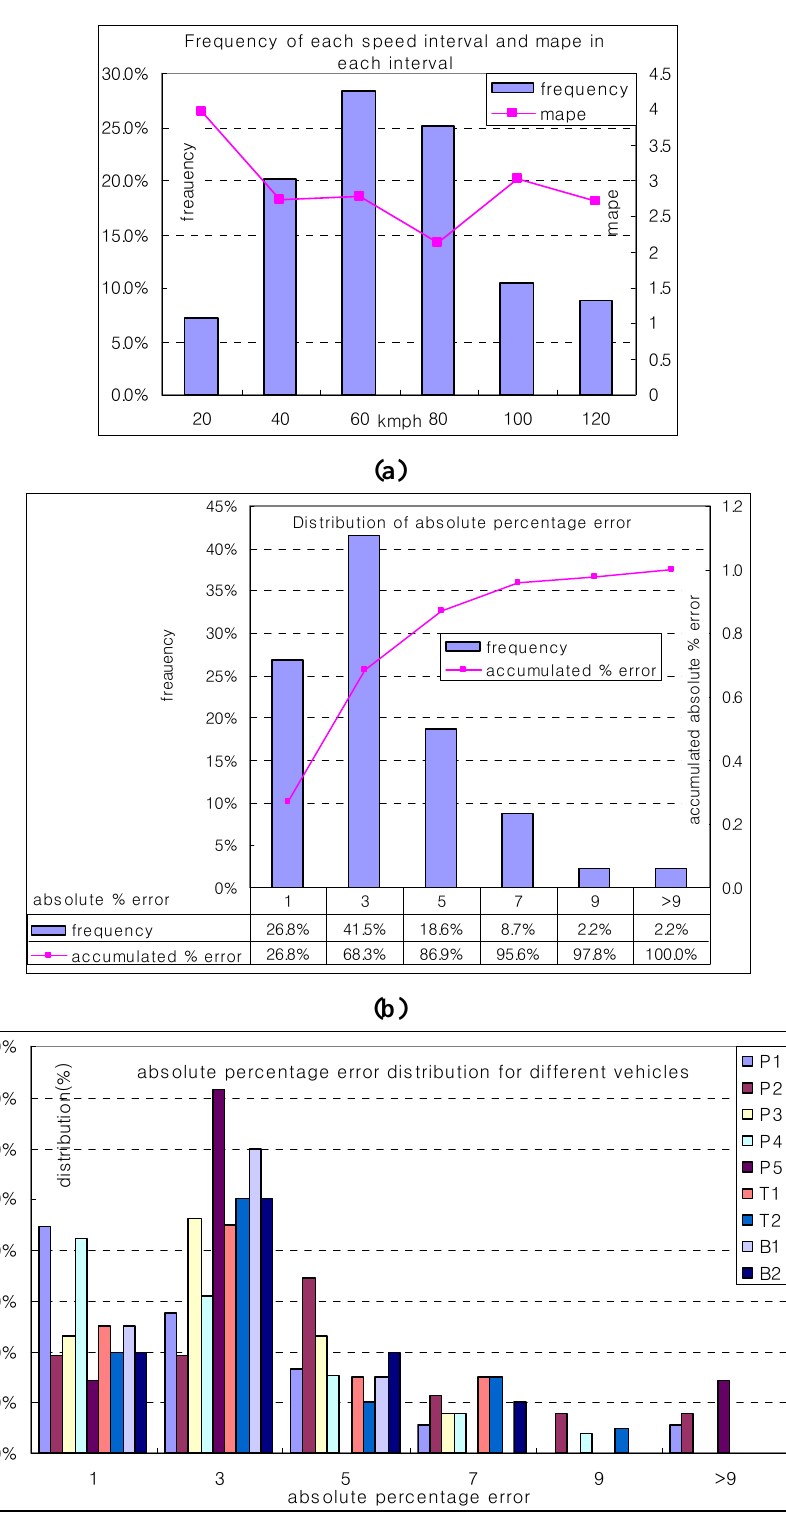
Figure 10. (a) Speed distribution (in the left vertical axis) and MAPE (in the right vertical axis) for each speed interval. (b) Absolute percentage error distribution in measured speed. Horizontal axis represents absolute percentage error. Left vertical axis means frequency of each absolute percentage error. Right vertical axis indicates accumulated distribution of absolute percentage error. (c) Absolute percentage error distribution for different